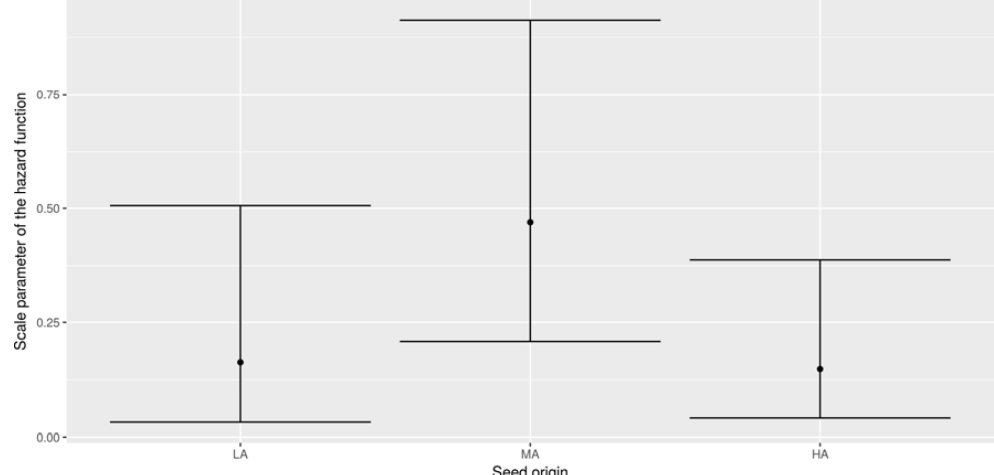
Figure 6. Scale parameter of the hazard function for emergence at the greenhouse for each seed origin (MA: P. nigra from typical distribution, HA: P. nigra from upland forests distribution, LA: P. nigra from lowland forests distribution). The error bars indicate the 95% credible interval.